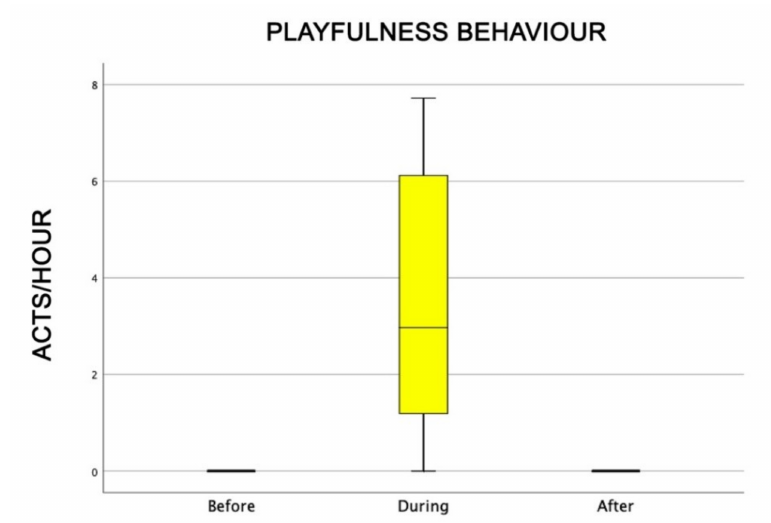
Figure 7. Behavioural patterns related to dogs’ playful behaviour towards humans before, during, and after AAI sessions. Non-parametric data are represented as medians (horizontal bar in the box) and the box indicates the interquartile range of 50% of the data. Whiskers extend to the smallest and largest values and exclude outliers (dot on top).